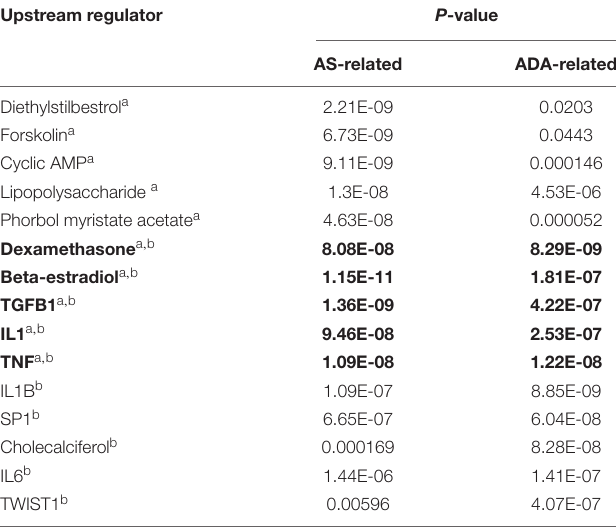
TABLE 3 | Top predicted upstream regulators of AS-related or ADA-related